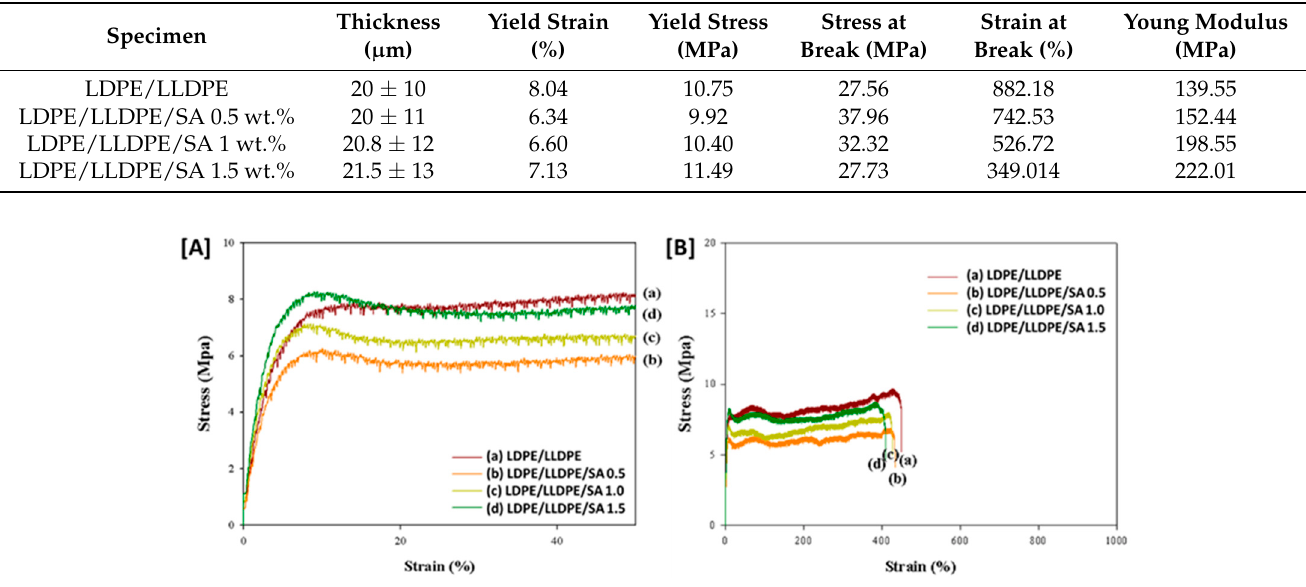
Figure 6. The stress–strain curve for the LDPE/LLDPE blend polymer film with various SA contents: (a) 0 wt.%, (b) 0.5 wt.%, (c) 1 wt.%, and (d) 1.5 wt.%. ( A ) from 0 to 90% and ( B ) from 0 to 1000%. The samples were cut along the TD. Table 3. The mechanical properties of the LLDPE/LDPE/SA (0–1.5 wt.%) air blown composite films along the TD.